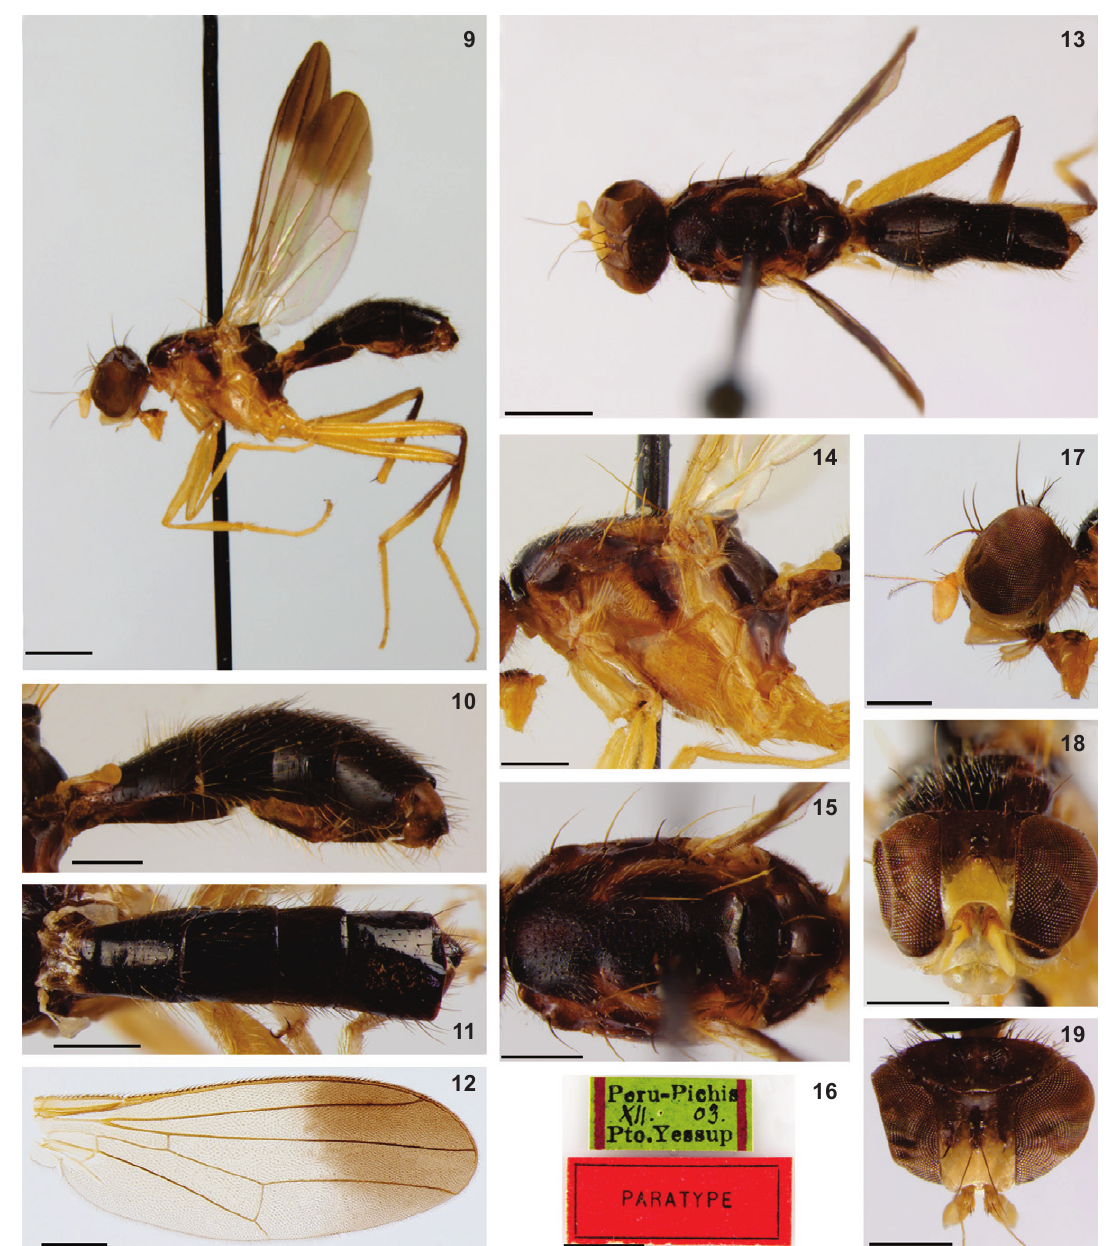
Figures 9-19. Odontomerella flavipleura (Hennig): (9, 10, 13-19) paratype male (SMTD); (11, 12) non-type material; (9) habitus, lateral view; (10, 11) abdomen: (10) lateral view; (11) male (USNM), dorsal view; (12) female (MHNJP), left wing, dorsal view; (13) habitus, dorsal view; (14, 15) thorax: (14) lateral view; (15) dorsal view; (16) label; (17-19) head: (17) lateral view; (18) frontal view; (19) dorsal view. Scale bars: 9, 13 = 1.0 mm, 10-12, 14-15, 17-19 = 0.5 mm, 16 = 5.0